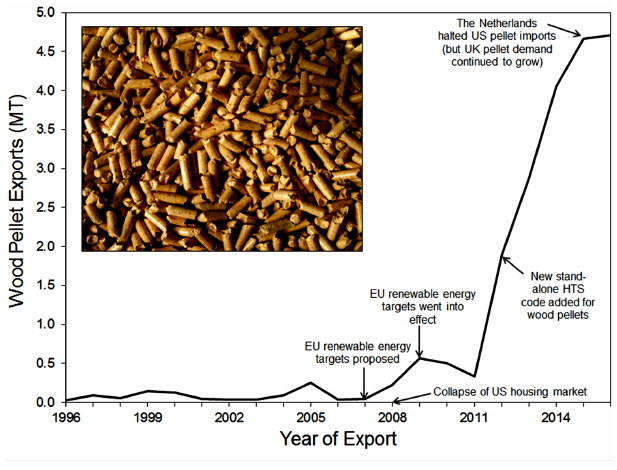
Fig. 2. Annual total U.S. wood pellet exports to all countries from 1996 to 2016 (USITC 2017). In 2012, a new stand-alone Harmonized Trade Schedule (HTS) code 4401310000 was introduced for “Wood pellets,” but previously, wood pellets were included in HTS code 4401300000, “Sawdust and wood waste or scrap, whether or not agglomerated in logs, briquettes, pellets or similar forms.” The line shows changes in HTS code 4401300000 before 2012 and in HTS code 4401310000 for 2012 and years thereafter.